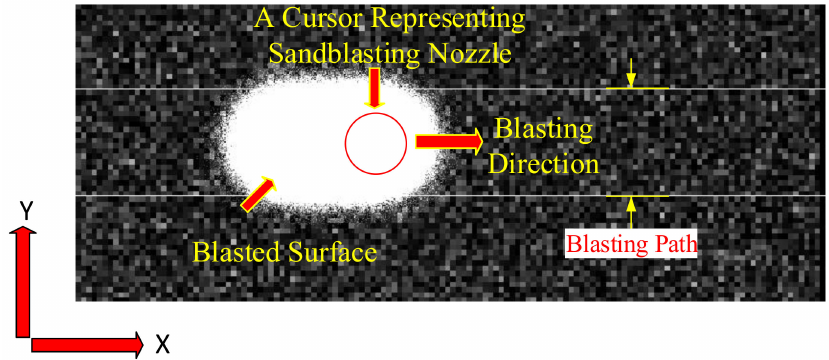
Figure 6. Surface to be blasted in the experiment.